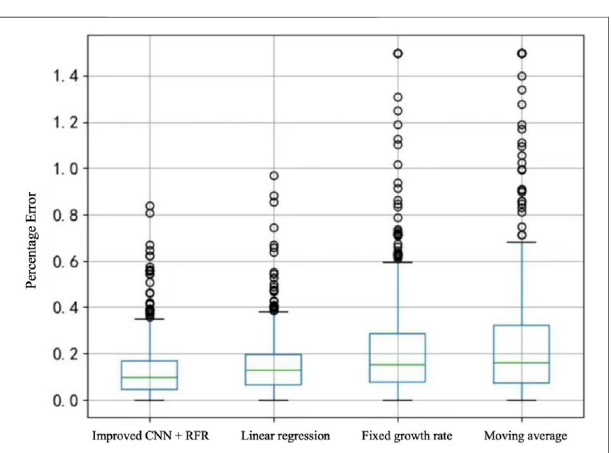
FIGURE 12 | Error box diagram of forecasting results by different